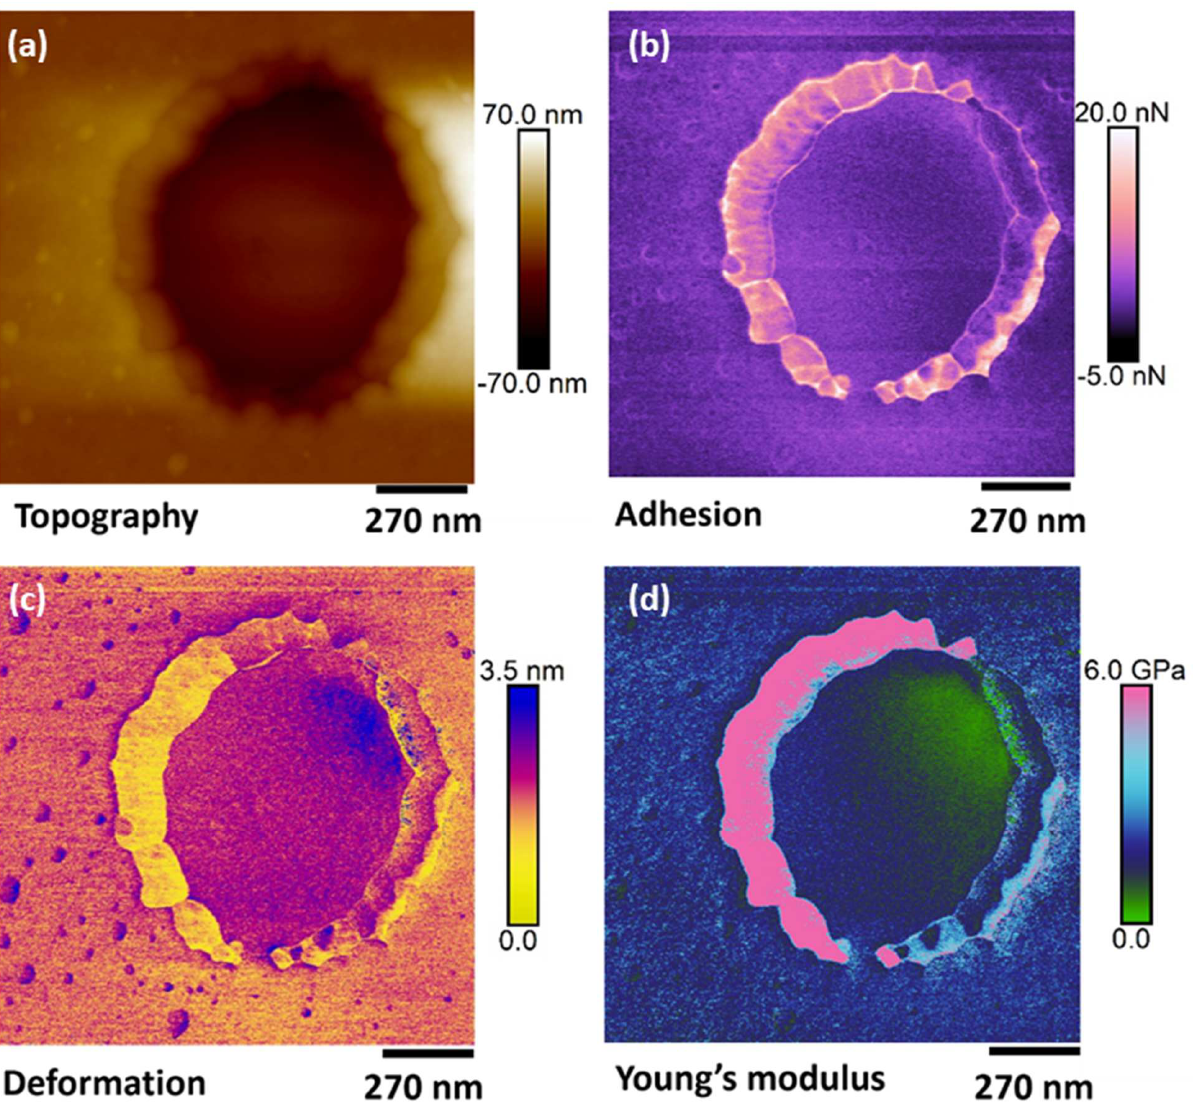
Figure 4. Freely suspended CNM membranes. The topography of suspended ( a ) Active layer of a CNM transferred from a composite membrane and ( b ) PVBP CNM.